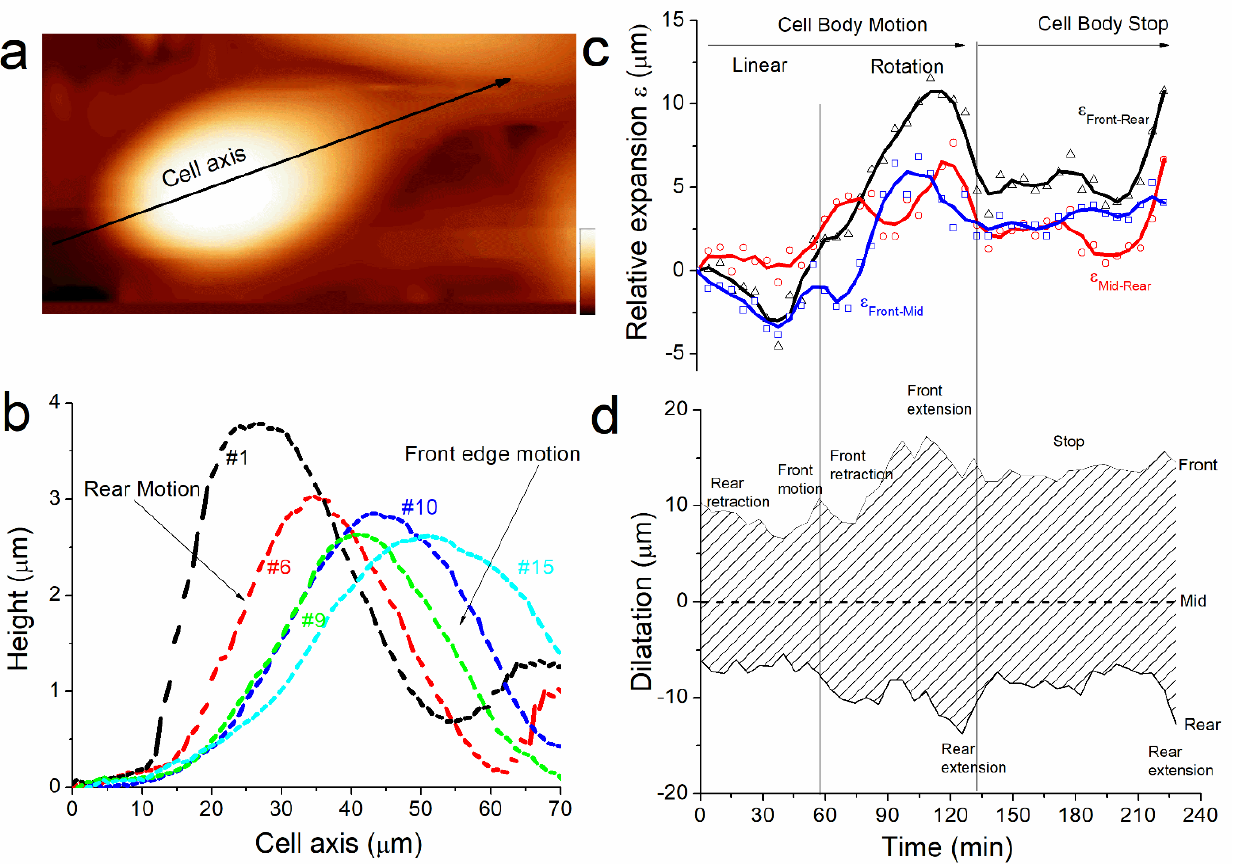
Figure 5. ( a ) Topographical image of the cell (70 µm × 31 µm) at t = 0 min that shows the cell axis where the profile is measured (black arrow). Z-scale = 3.5 µm. ( b ) Profiles of the topographical images along the cell axis with respect to their traveled distance for t = 6, 34, 51, 57, 86 min respectively (images 1, 6, 9, 10 and 15 respectively). Real time plot of the, ( c ) relative expansion, and ( d ) dilatation, during cell motion that shows the different phases of rear retraction and front extension, rotation, and stop of the cell.